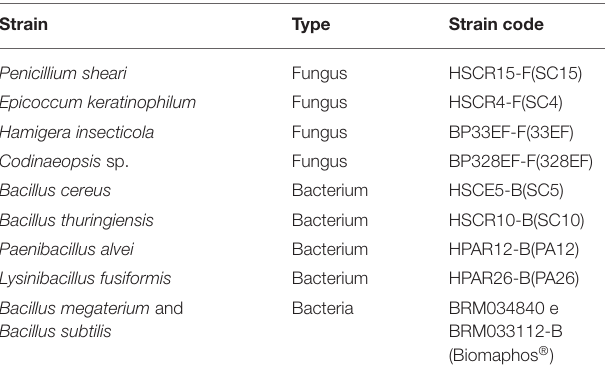
TABLE 1 | Microbial strains were used to compare experimental methodologies for the evaluation of the solubilization capacity of calcium phosphate (CaHPO 4